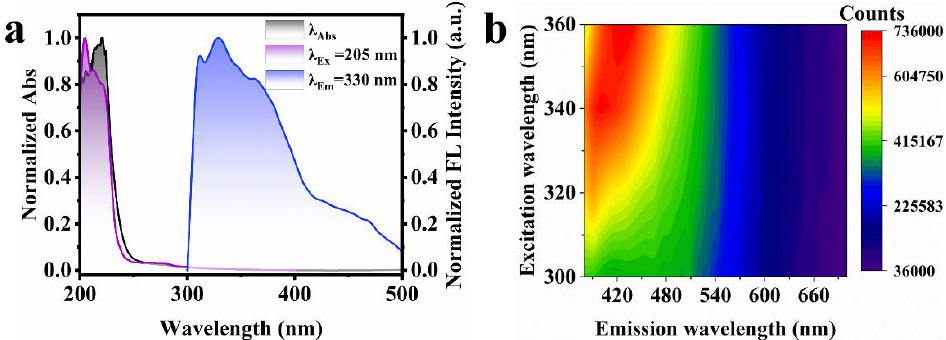
Figure 7. ( a ) The normalized UV absorbance, FL excitation and emission spectra of AA-CPDs1 in water. ( b ) Fluorescence spectra of the solid